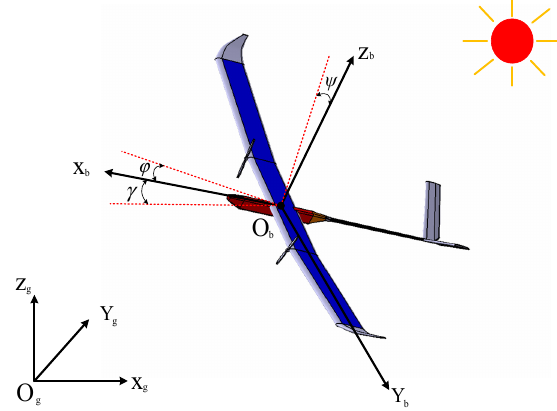
Figure 3. Schematic diagram of earth-fixed frame and aircraft body-fixed frame.